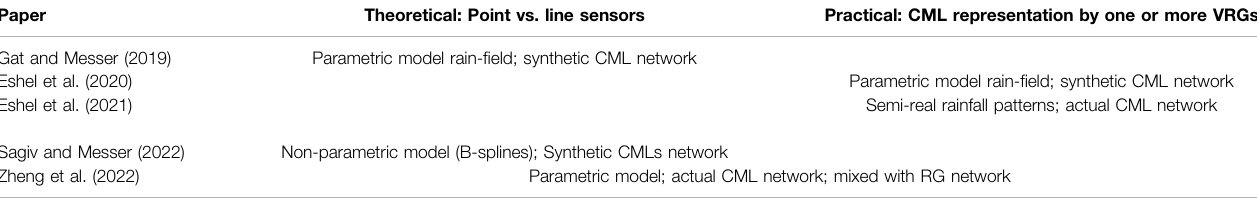
TABLE 1 | Categorization of the relevant studies referred to in this study.